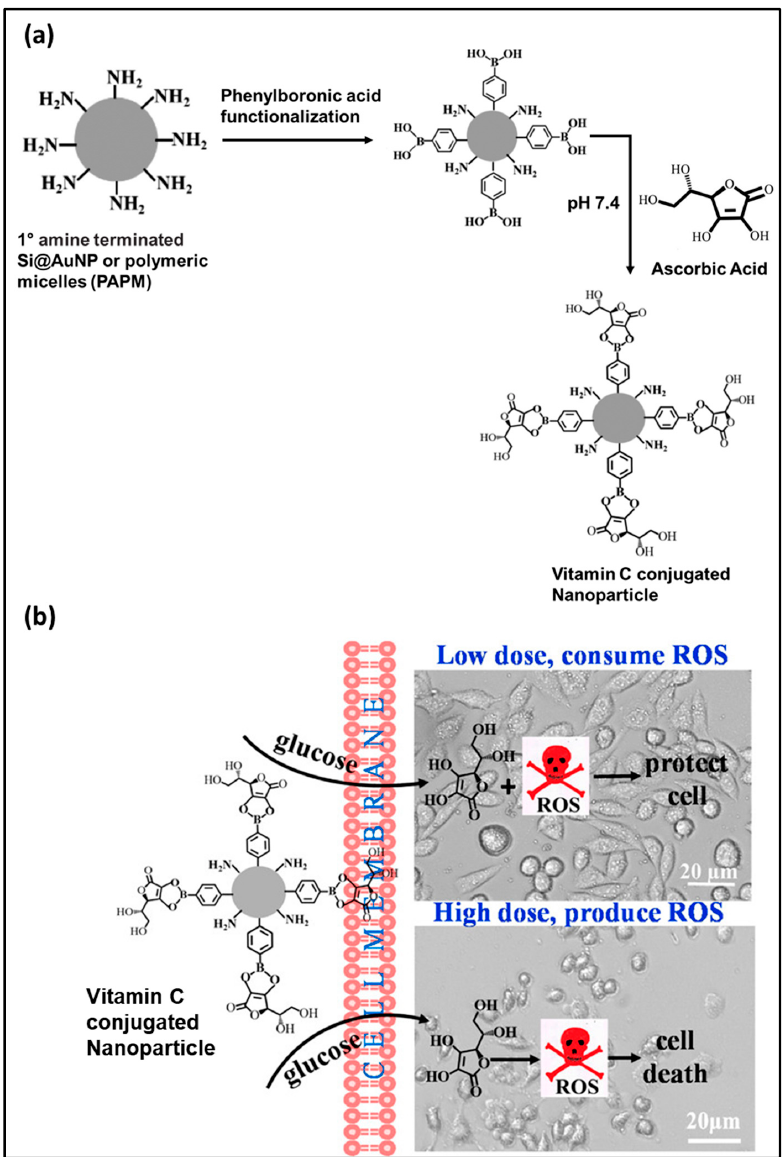
Figure 5. ( a ) Schematic presentation on the synthesis of vitamin C conjugated nanoparticles (Si@AuNP or PAPM) and ( b ) cellular oxidative stress at micro and millimolar concentration of vitamin C. Adapted with permission from Ref. [32]. Copyright American Chemical Society,